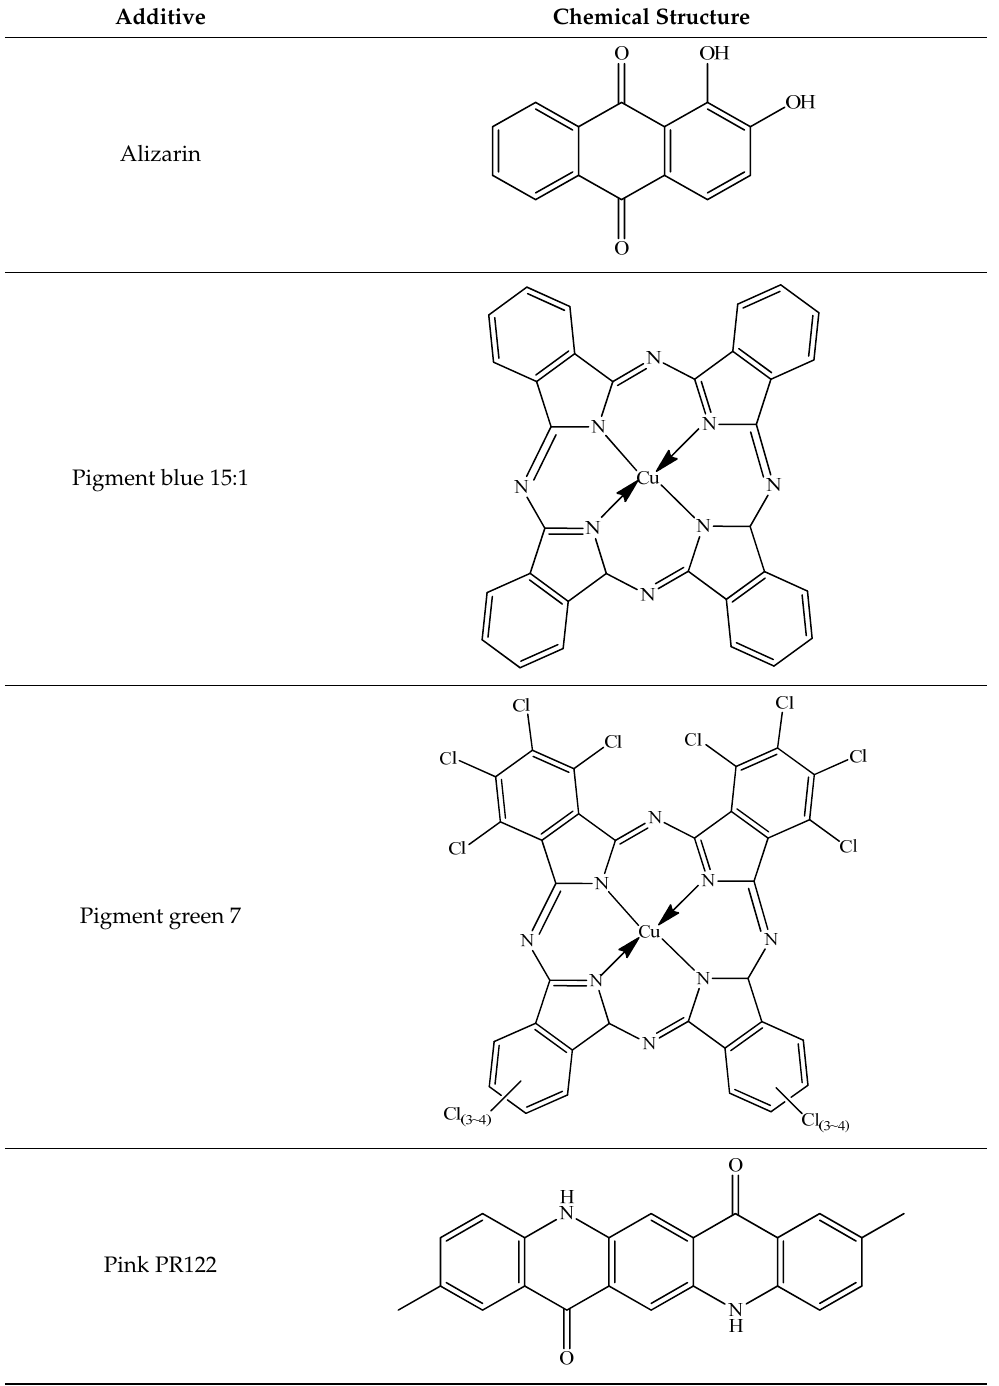
Table 1. Chemical structure of the colorants [23–27].